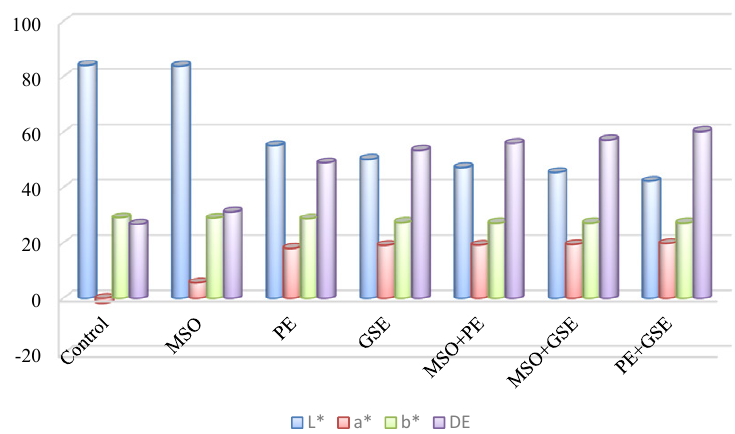
Fig. 4. Color of nanochitosan film incorporated with M. spicata essential oil (MSO), pomegranate peel extract (PE) and grape seed extract (GSE)